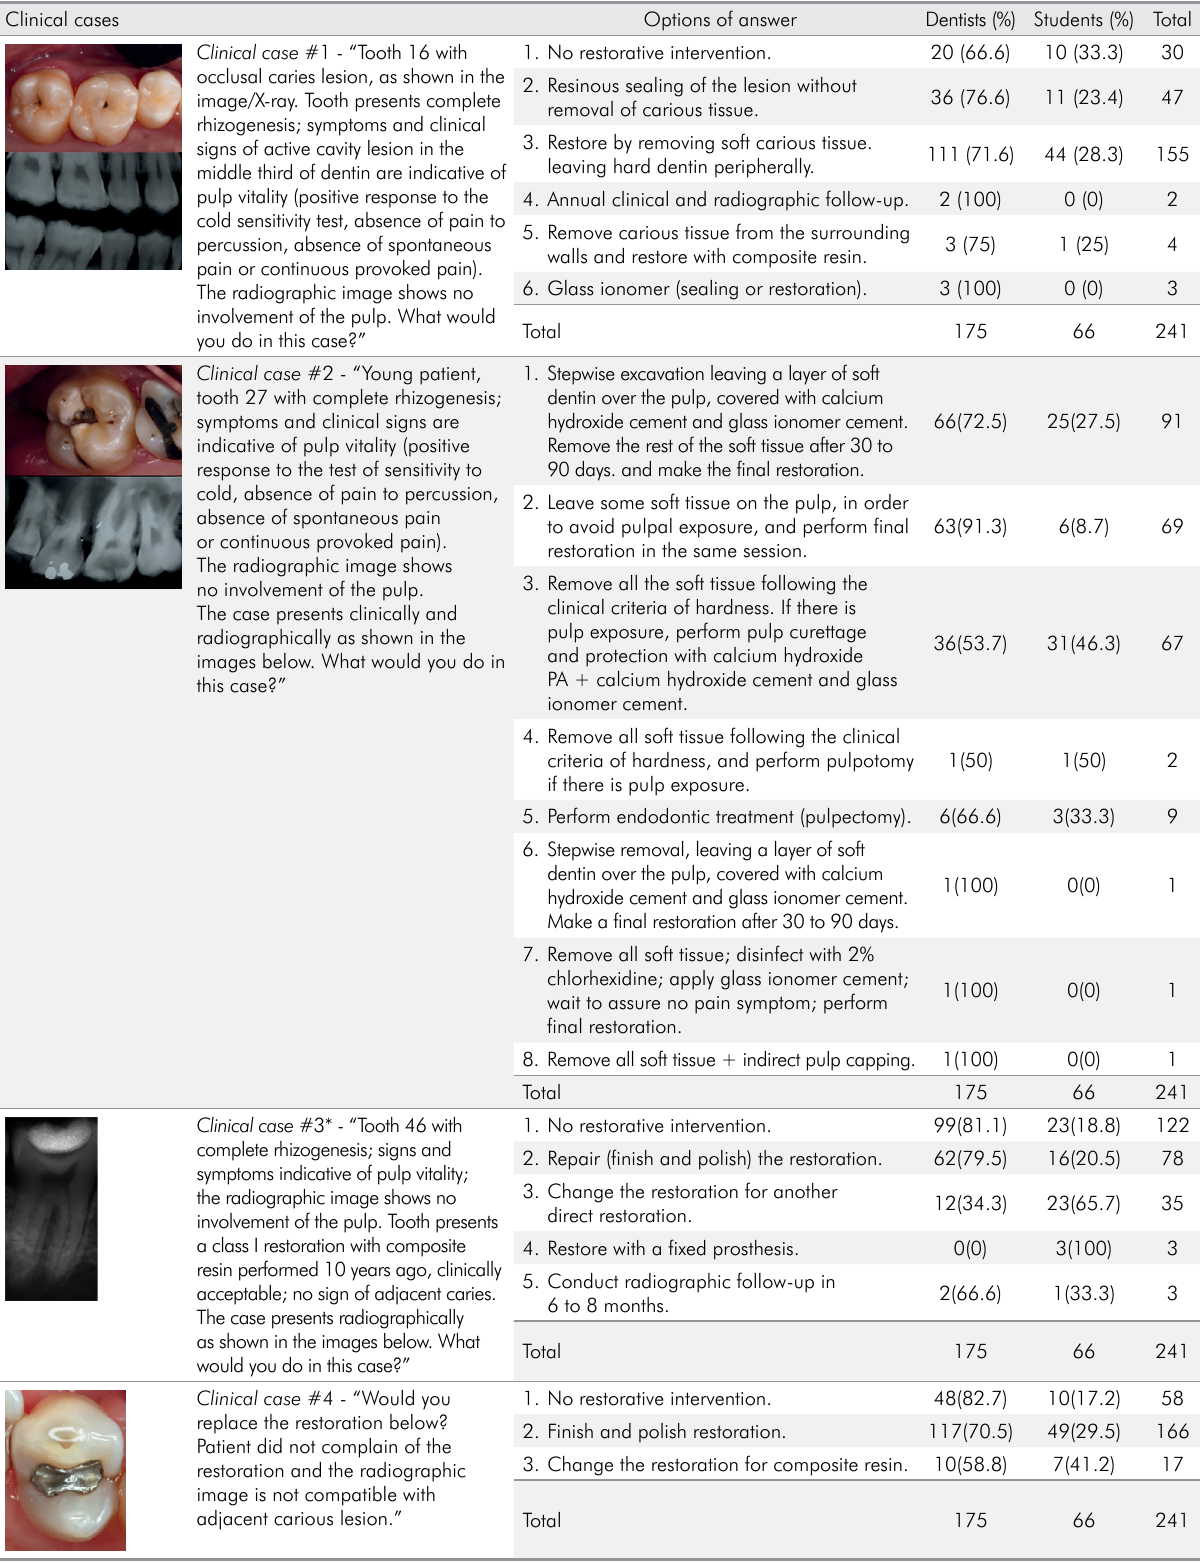
Table 2. Description of the clinical cases and answers. Clinical cases Options of